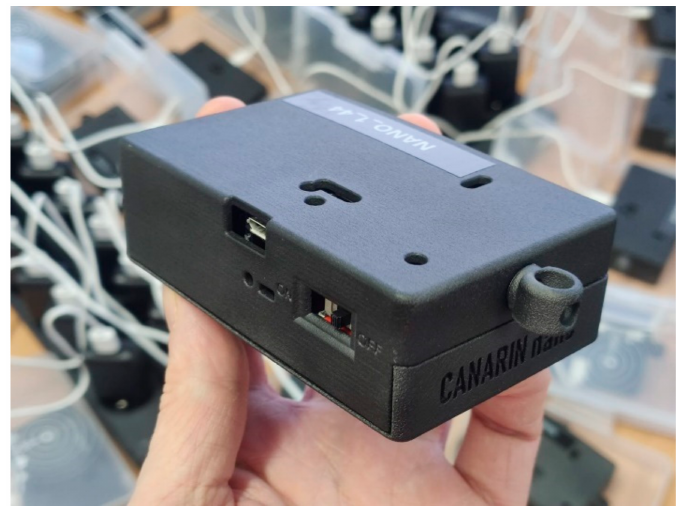
Figure 1. A Canarin Nano. The hook in the foreground is for carrying the